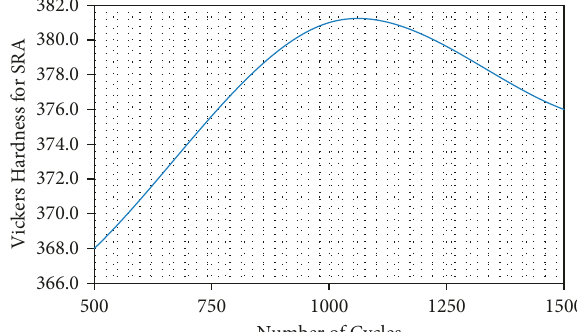
Figure 10: Vickers hardness of WHT.